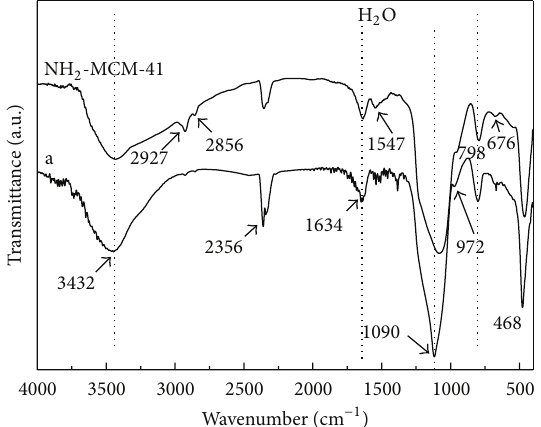
Figure 2: FTIR spectra of MCM-41 and NH 2 -MCM-41.